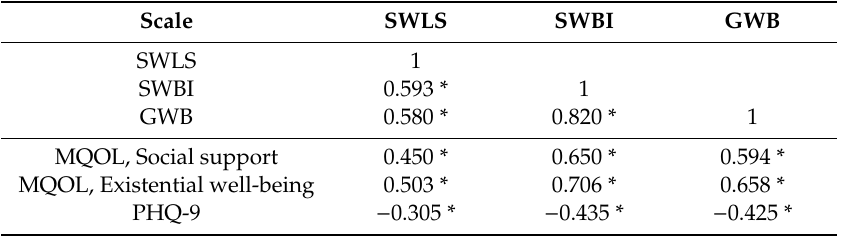
Table 3. Correlations among the mean values of the Satisfaction with Life Scale (SWLS), Subjective Well Being Index (SWBI), Global Well-Being (GWB), McGill Quality of Life (MQOL) and Patient Health Questionnaire-9